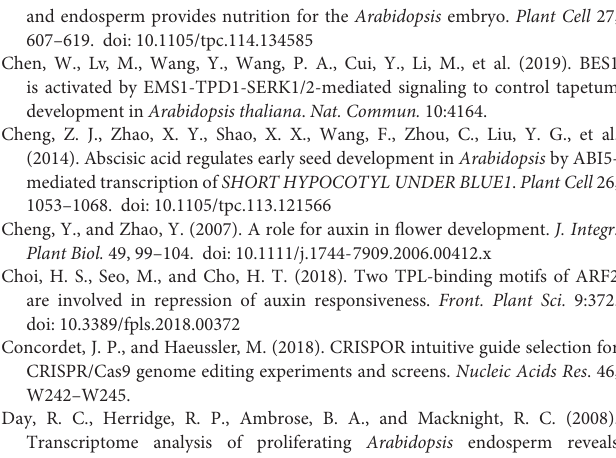
Supplementary Figure 1 | Expression level-dependent aerial and silique phenotypes of AIF2-overexpressing independent transgenic lines ( p35S:AIF2-EGFP /Col-0, AIF2ox). Supplementary Figure 2 | Expression of the native promoter-driven and CaMV35S promoter-driven AIF2 protein in floral organs. Supplementary Figure 3 | Reduced pollen production in AIF2ox plants. Supplementary Figure 4 | Efficacy of in vitro -germinated pollen tube growth. Supplementary Figure 5 | Relative expression of AIF2 (At3g06590) in developing seeds. Supplementary Figure 6 | Morphology of seeds stained with mPS-PI, followed by confocal microscope observation. Supplementary Table 1 | Primers used in cDNA amplification of AIF2 . Supplementary Table 2 | Primers used in quantitative real time RT-PCR